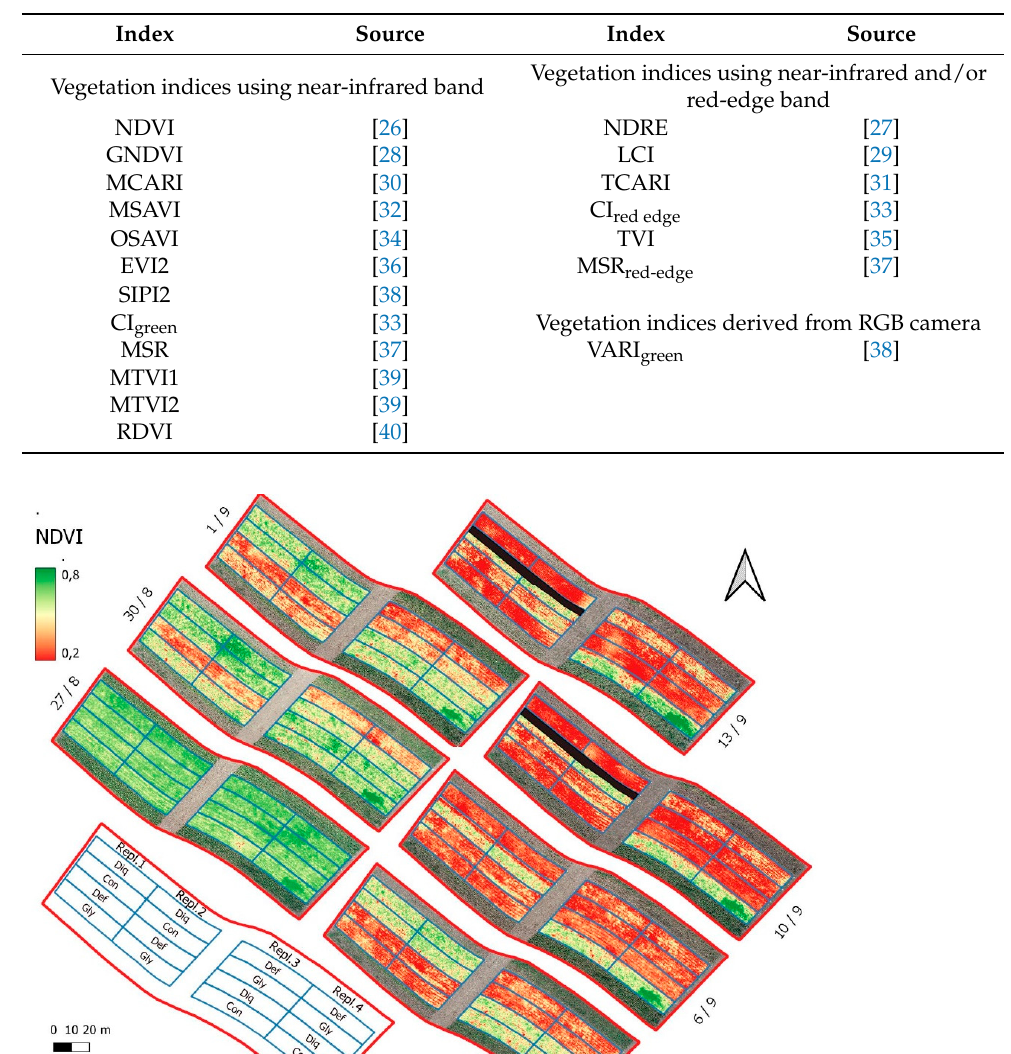
Table 1. List of vegetation indices estimated from multiband images from the two cameras.